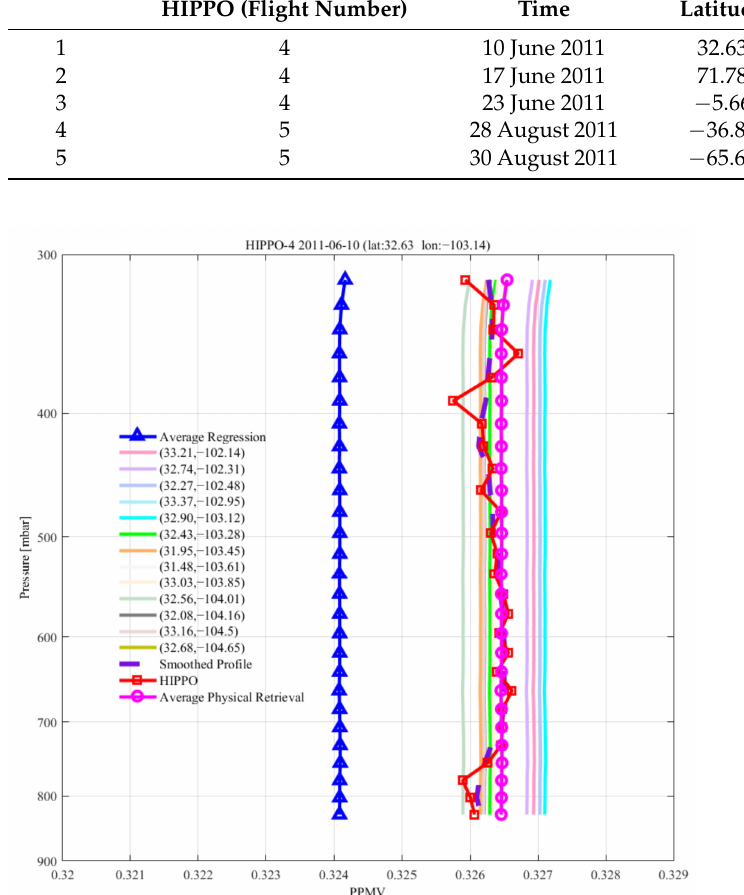
Figure 9. An example of the retrieval results for the mid-latitude region of the Northern Hemisphere.